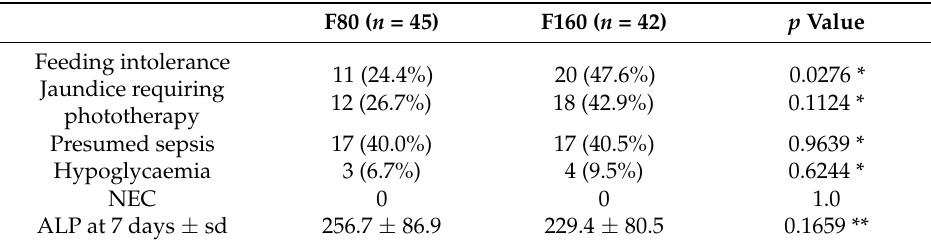
Table 5. Frequency of Clinical Outcomes.